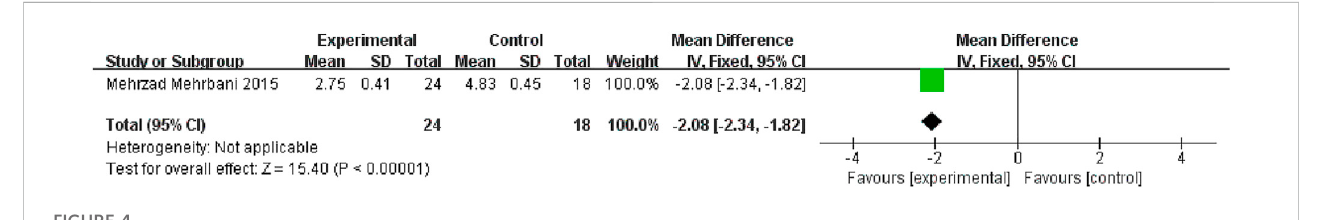
FIGURE 4 The results of the meta-analysis for the effect of traditional Chinese medicine and placebo on